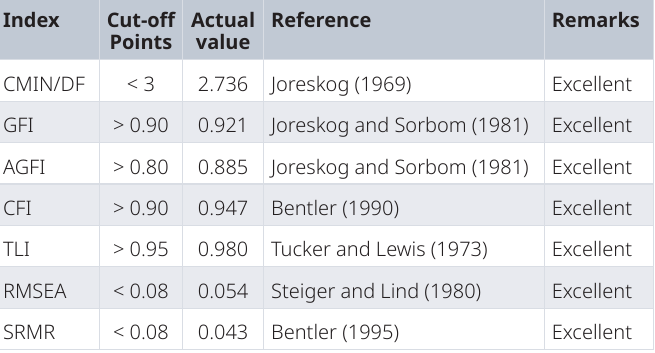
parameter estimate. The independent variables (determining and risk factors) accounted for approximately (R 2 = 0.436; R 2 = 0.483) 43.6% and 48.3% of the variance in the academic staff retention (ASR) and sustainable performance (SP) of univer- sities. The path coefficients and structural model results were demonstrated in Figure 1–Figure 3, respectively. The path coef- ficients for retention strategies and sustainable